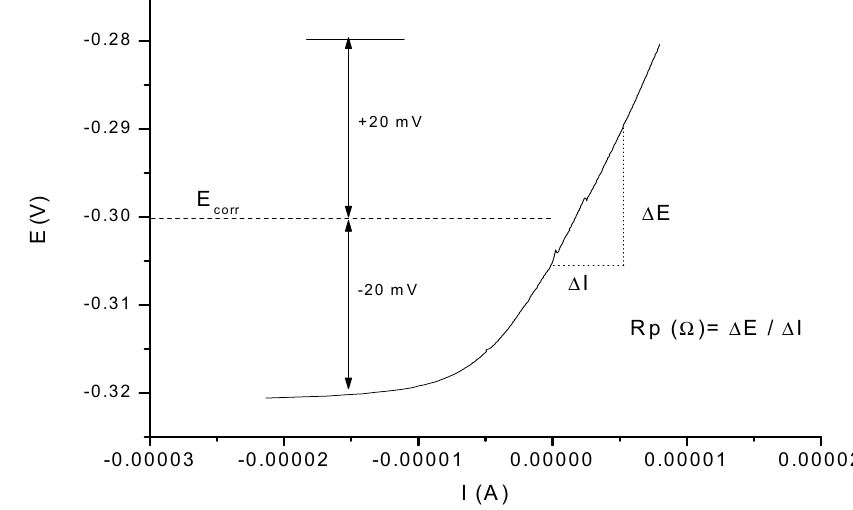
Figure 5. Typical curve of a lineal polarization resistance (LPR) test.